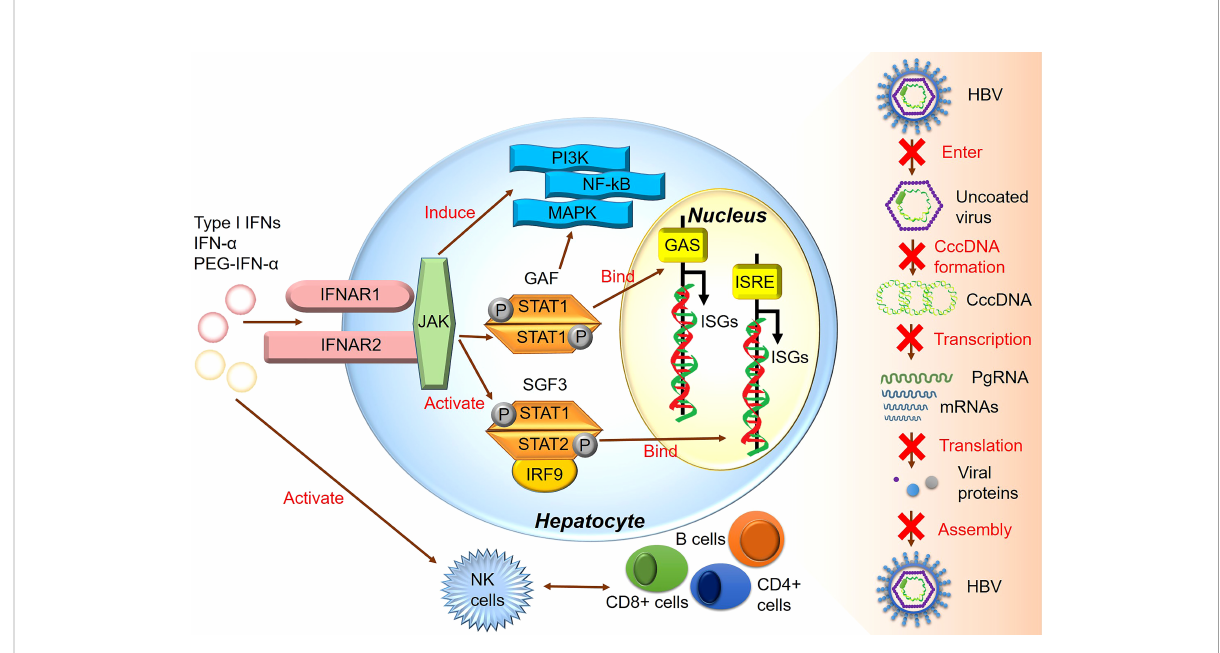
FIGURE 2 The major signaling pathway through which IFN produces its inhibitory effect on